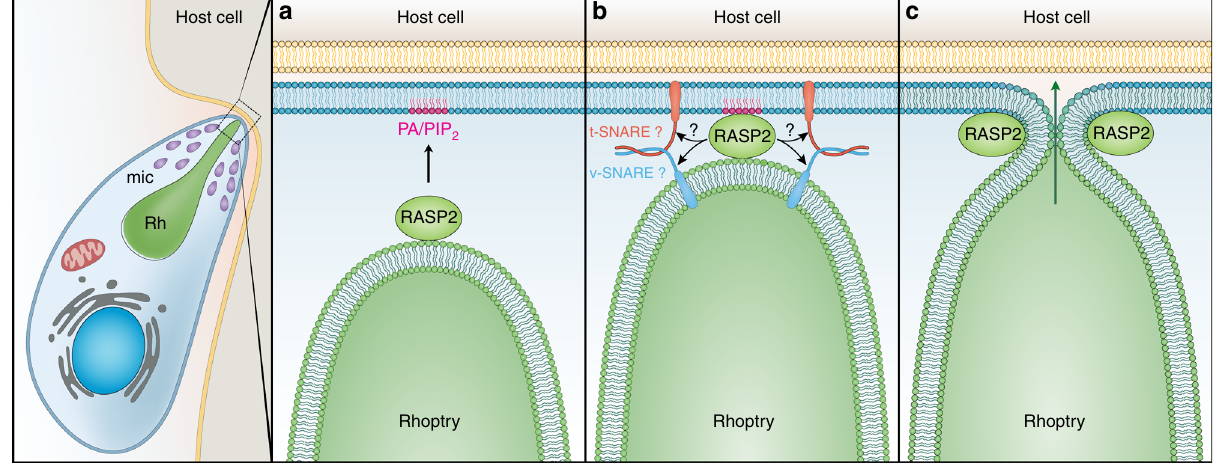
Fig. 8 Model of RASP2 rhoptry docking/priming function in apicomplexan parasites. Upon response to an unknown signal, RASP2 binds to phospholipids (PA/PIP2) ( a ). This promotes association of the rhoptry with the parasite plasma membrane to initiate the assembly of the docking/priming machinery of the rhoptry ( b ), which results in membrane fusion, an essential step before the release of the rhoptry contents into the host cell ( c